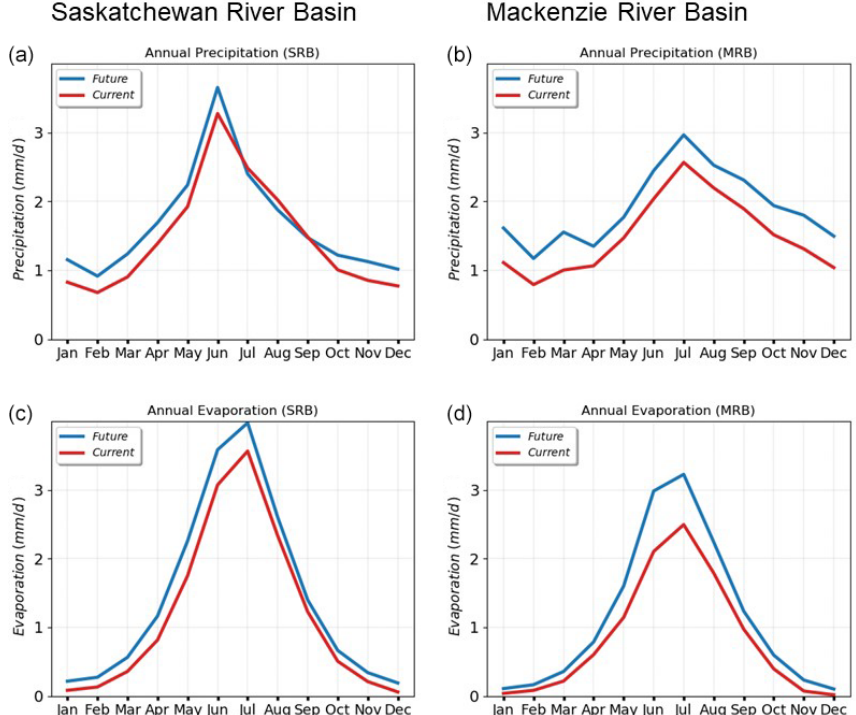
Figure 2. Simulated P and ET surface water budget components (mmd − 1 ) over the Saskatchewan (a, c) and Mackenzie (b, d) River Basins for the WRF control (current; 2000–2015) and future (2085–2100) periods. Results are from Kurkute et al. (2020).